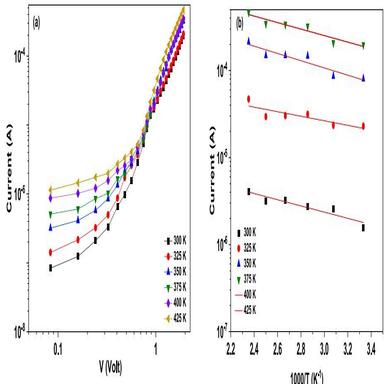
(a) Plot of forward I–V characteristics, and (b) Plot of current, I vs. 1000/T at different applied voltages of PVA/p-Si heterojunction.